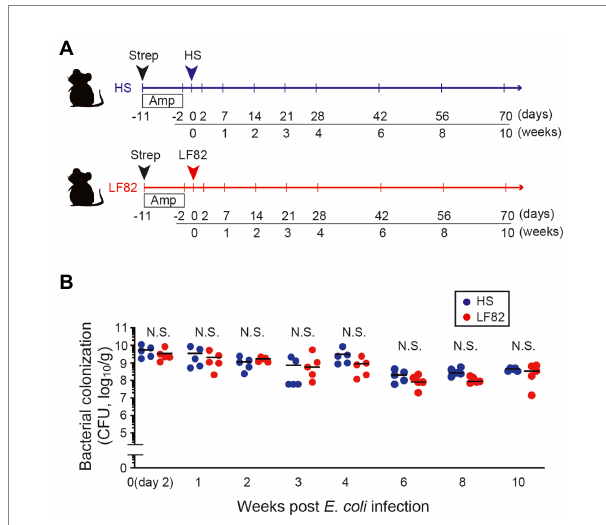
FIGURE 1 AIEC colonization persists after antibiotics are administrated. (A) SPF female C57BL/6 mice were treated with 20 mg streptomycin (Strep) followed by 1 g/L ampicillin (Amp) in drinking water for 9 days. Two days later, Strep/Amp-treated mice were inoculated with human commensal E. coli strain HS or human AIEC strain LF82 (1 × 10 9 CFU/ mouse). (B) Intestinal colonization (in feces, log 10 /g) of E. coli . Dots represent individual mice. Bars indicate median. N.S., not significant by 2-Way ANOVA with Bonferroni post-hoc